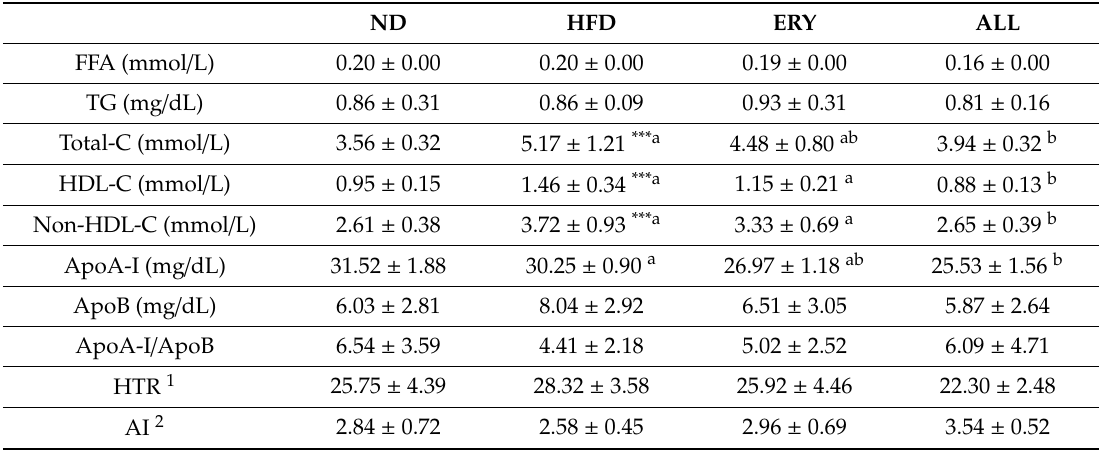
Table 2. E ff ect of D-allulose supplementations for 16 weeks on plasma lipid profiles in C57BL / 6J mice fed a high-fat diet.